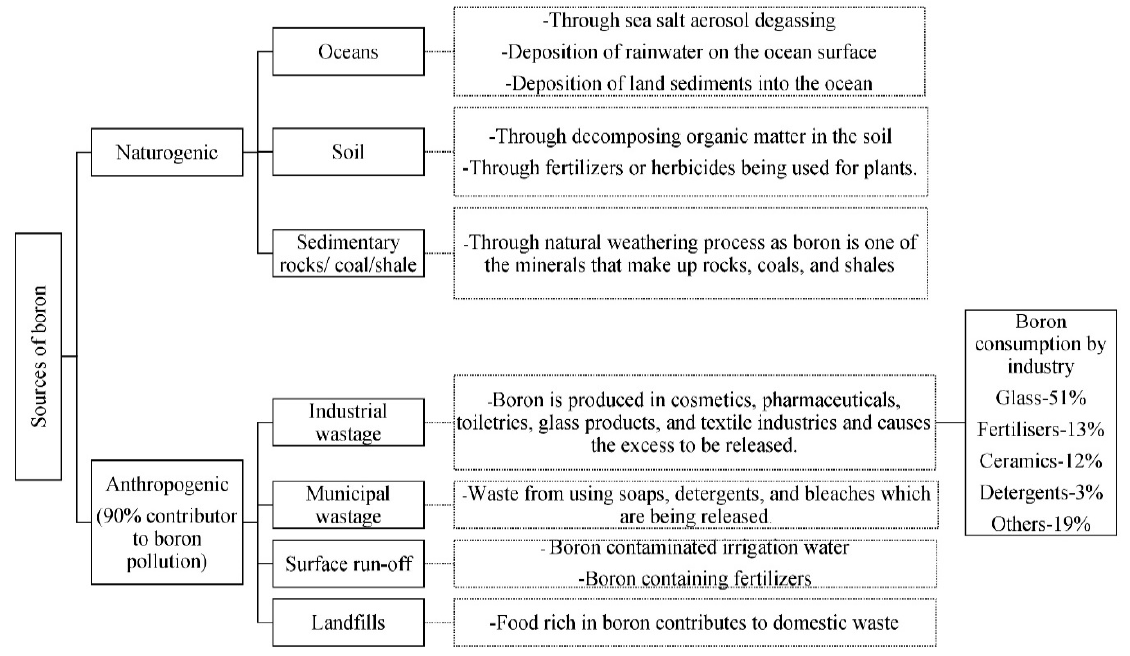
Figure 5. Summary on various sources and their respective processes accounting for boron concen- tration in the environment.